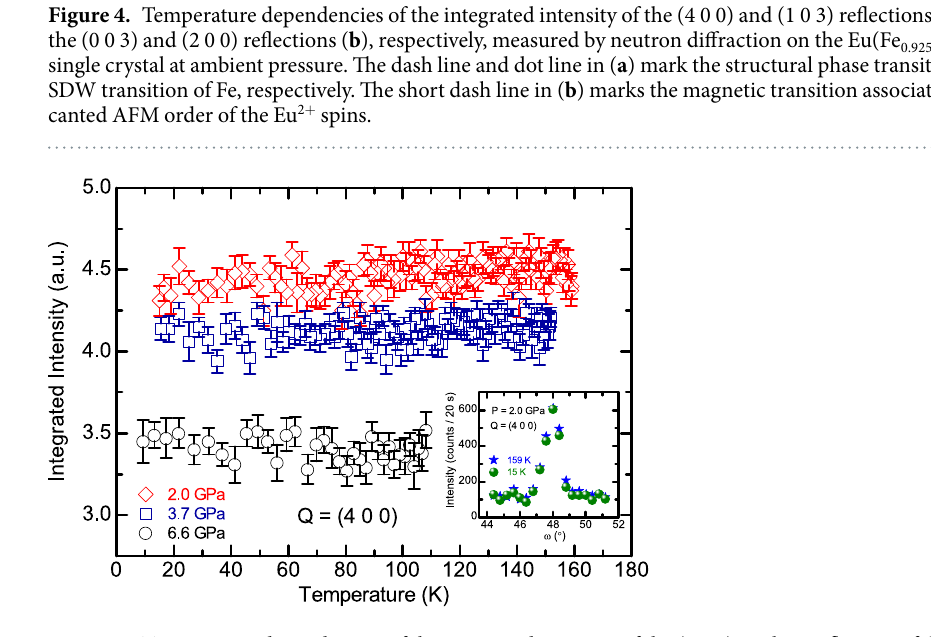
Figure 5. Temperature dependencies of the integrated intensity of the (4 0 0) nuclear reflection of the Eu(Fe 0.925 Co 0.075 ) 2 As 2 single crystal under the high pressure at 2.0 GPa, 3.7 GPa and 6.6 GPa, respectively. The rocking scans of the (4 0 0) peak at 159 K and 15 K under the pressure at 2.0 GPa are shown in the